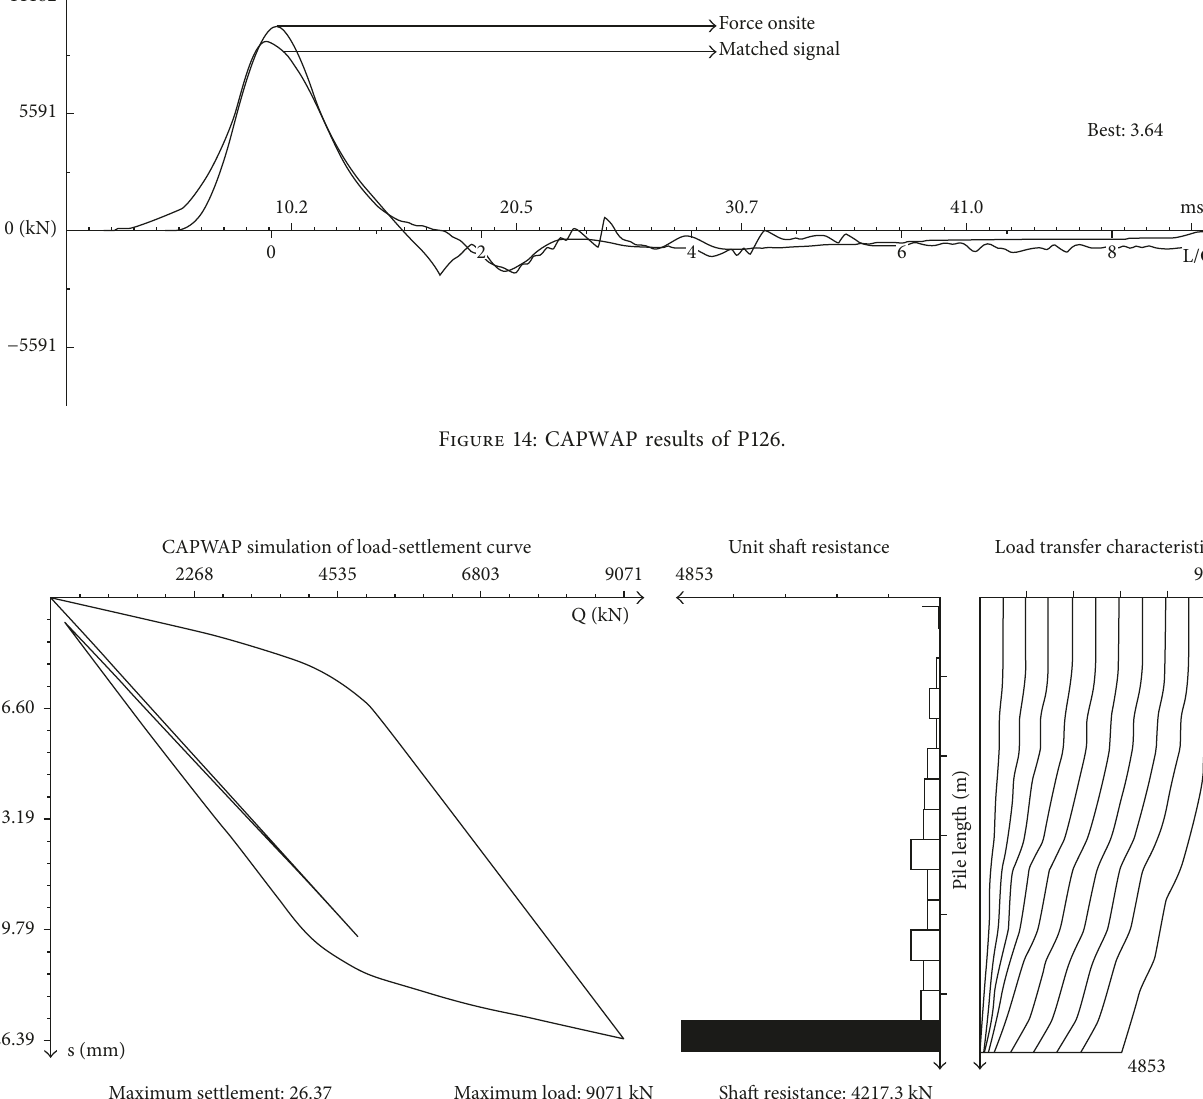
Figure 15: Simulated load-settlement curve, unit shaft resistance, and load transfer characteristic of P121.